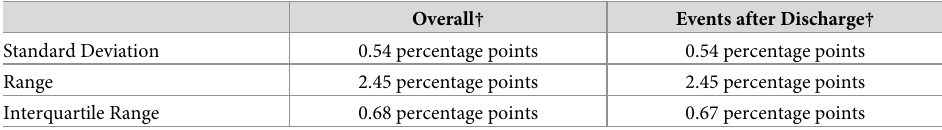
Table 3. Summary of measures of dispersion of penalty size within a